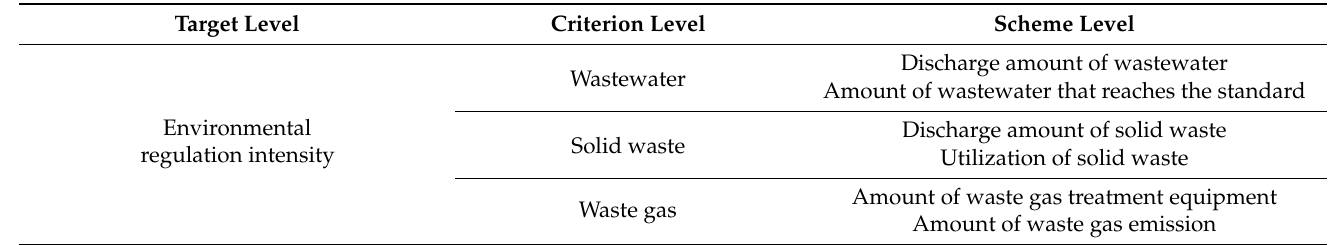
Table 3. The hierarchical analysis